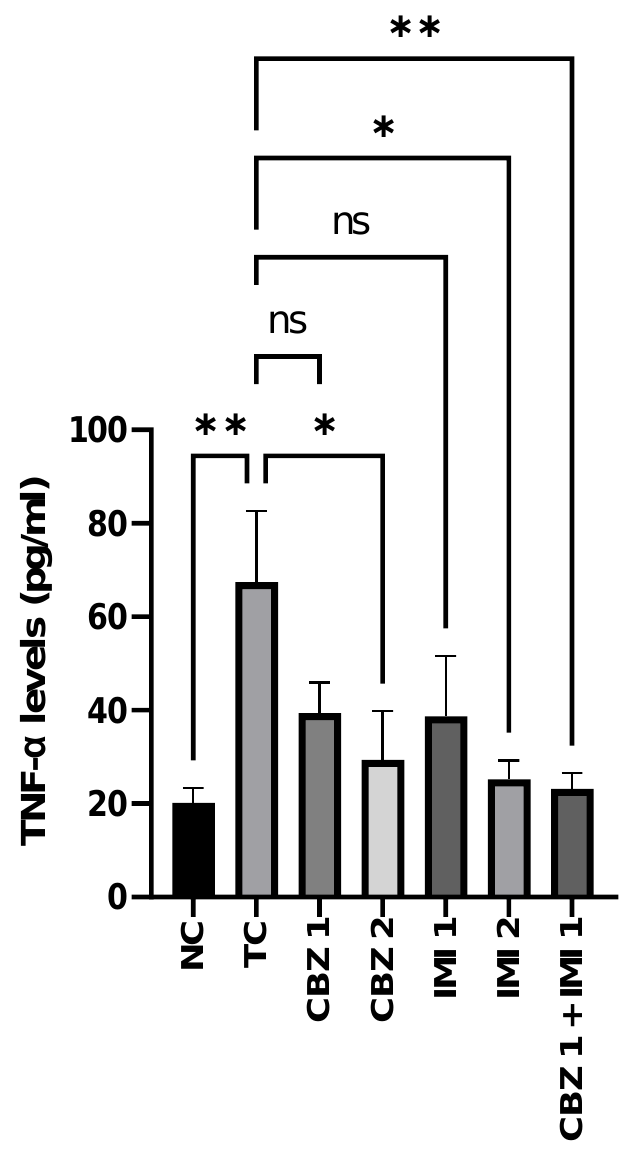
Figure 5. The effect of CBZ (20 and 50 mg/kg), IMI (10 and 20 mg/kg) and CBZ (20 mg/kg) + IMI (10 mg/kg) on hippocampal TNF- α levels. Statistical significance between means from toxic control and other groups was correlated by applying one-way ANOVA followed by post hoc Dunnet’s test. ( p < 0.05 *, p < 0.01 ** significance levels). CBZ, IMI, and TC indicate carbamazepine, imipramine, and toxic control, respectively.